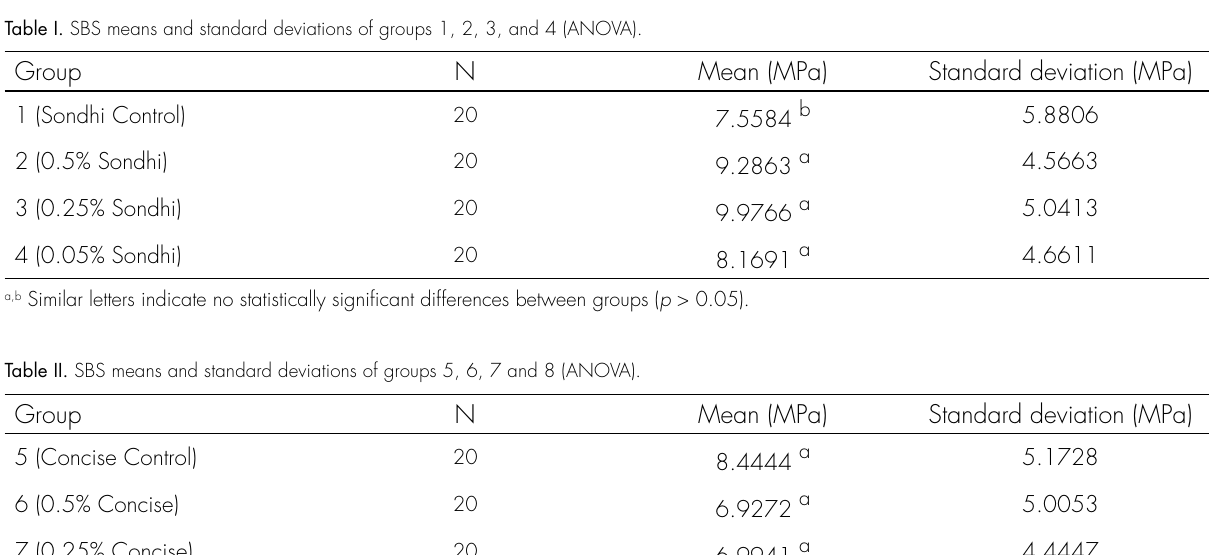
Table I. SBS means and standard deviations of groups 1, 2, 3, and 4 (ANOVA).